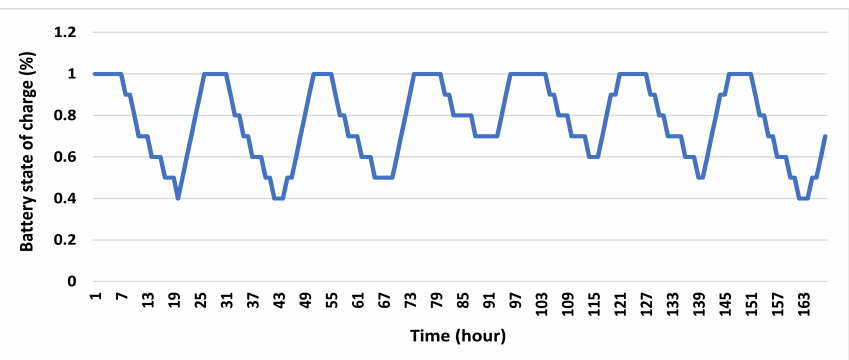
Figure 11. Battery state of charge during a week in the rainy season: Case